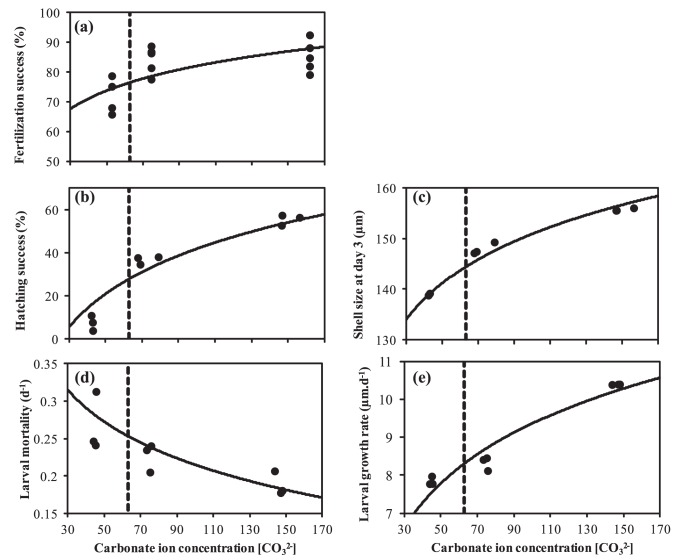

Macoma balthica: Relationships between seawater carbonate ion concentration [CO3
2−] and parameters of early life history processes.Fertilization (upper panel; a), embryogenesis (middle panel; b,c), and larval development (lower panel; d,e). The dashed lines refer to the carbonate concentration at the aragonite saturation level (Ωaragonite = 1). The fitted lines show the relationship between the CO3
2 concentration and the developmental parameter according to a Michaelis-Menten equation, e.g. Hatching success = Vmax[CO3
2−]/(Km + [CO3
2−]); where Vmax is the maximal hatching success and Km is the CO3
2 concentration were the reaction rate is the half of Vmax. Percentage of variation explained (r2) by the fitted lines are 0.45 (fertilization success), 0.90 (size at day 3), 0.86 (hatching success), 0.64 (larval mortality rate), and 0.87 (larval growth rate).